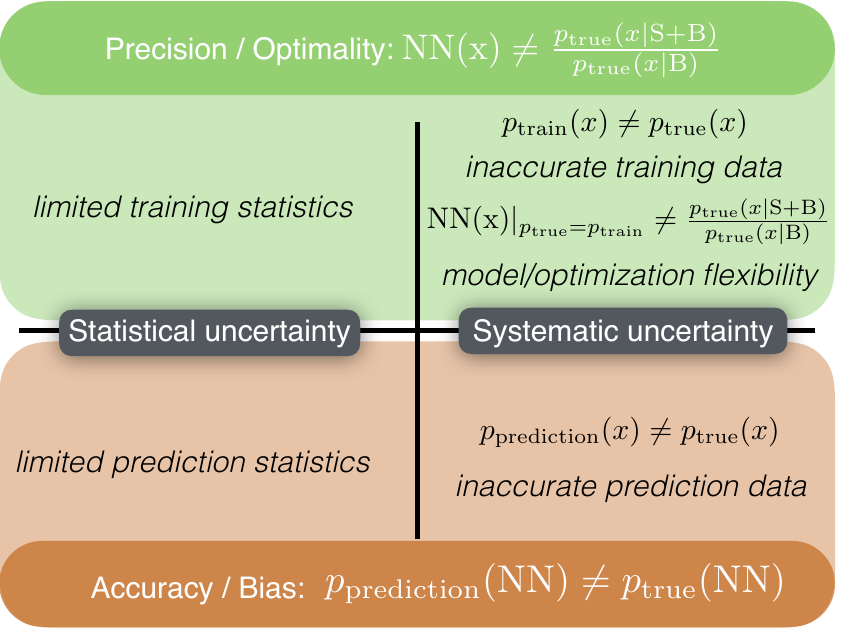
Figure 6: Sources of uncertainty affiliated with a neural network-based analysis. The symbol p is used to represent a probability density